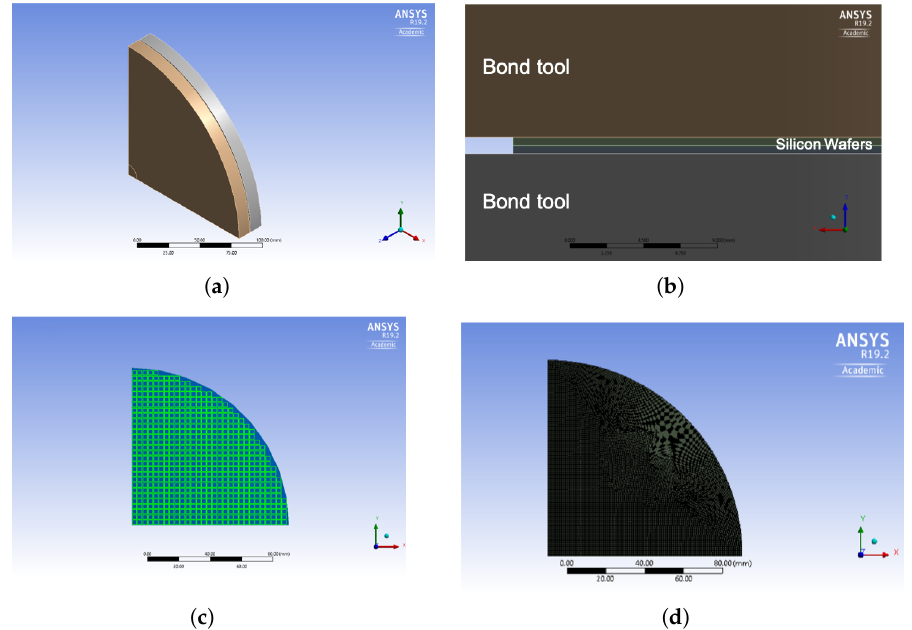
Figure 17. Finite element model of gf bonding: ( a ) one-quarter of the bonding chamber; ( b ) planar view of the FE model; ( c ) gf region; ( d ) FE model mesh.